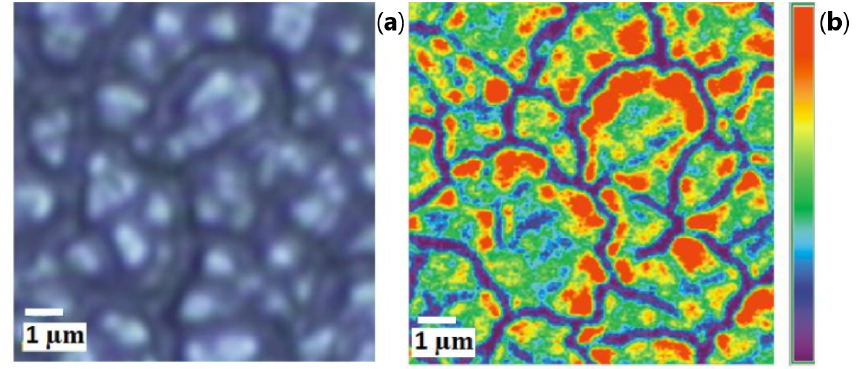
Figure 9. On ( a ), an optical image of 2400nm thick CeO 2 surface is displayed, and on ( b ), an intensity distribution map for the main Raman peak, whose Stokes shift is of 1338cm − 1 from the laser frequency